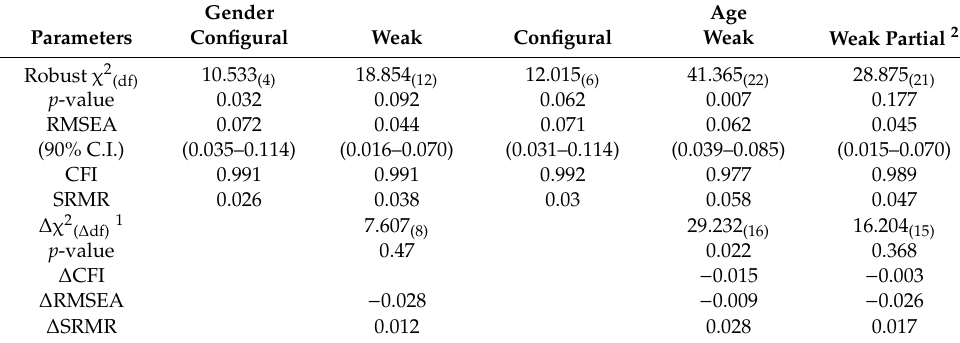
Table 4. All the steps and fit indices of the invariance analysis. Table 4. Model structural invariance and fit indexes.